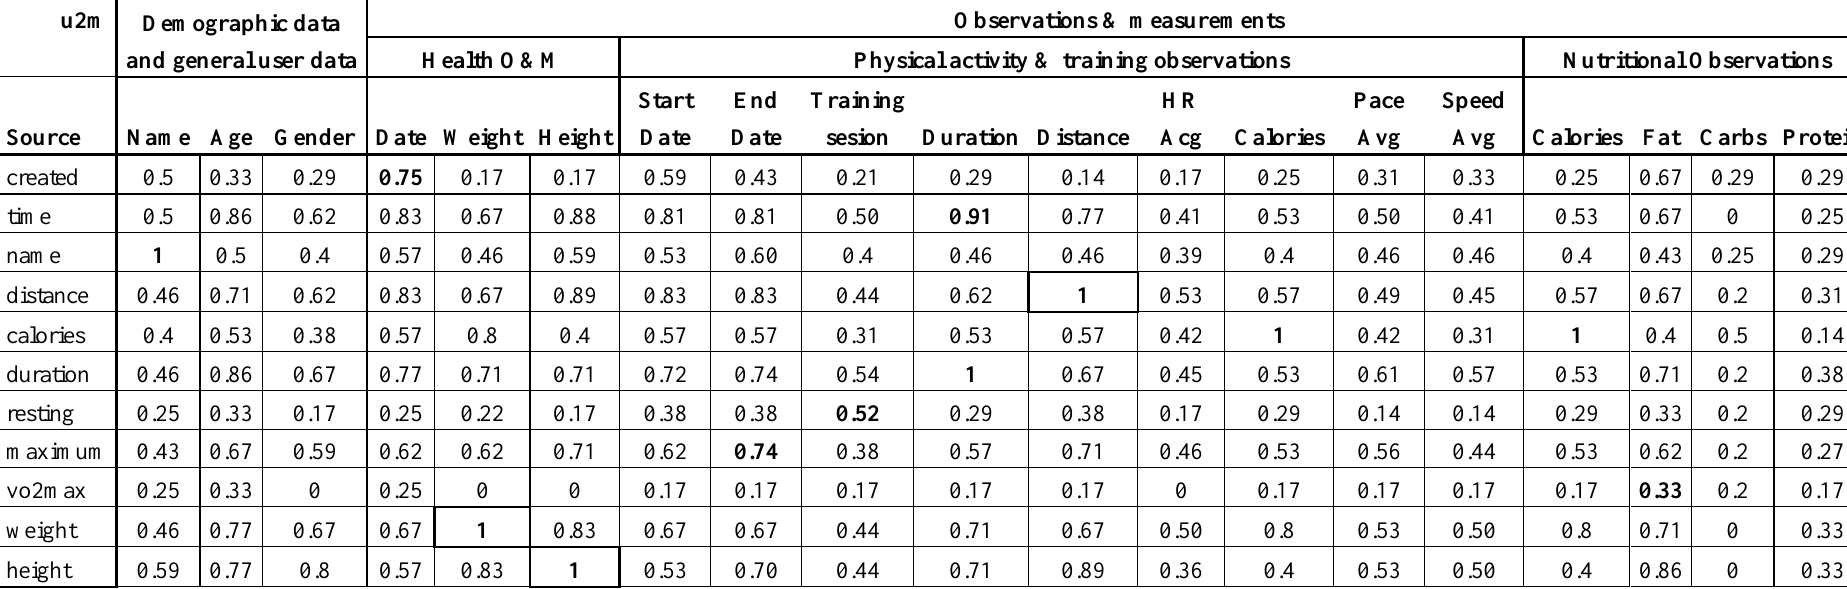
Table 3. Partial view of similarity matrix (XML Document concepts, ubiquitous user model